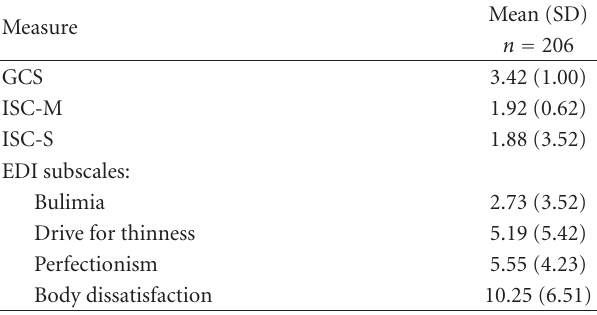
Table 1: Mean scores for the General Competitiveness Scale (GCS), Female Intrasexual Competition for Mates Scale (ISC-M), Intrasexual Competition for Status Scale (ISC-S) and shortened Eating Disorders Inventory (EDI-S).